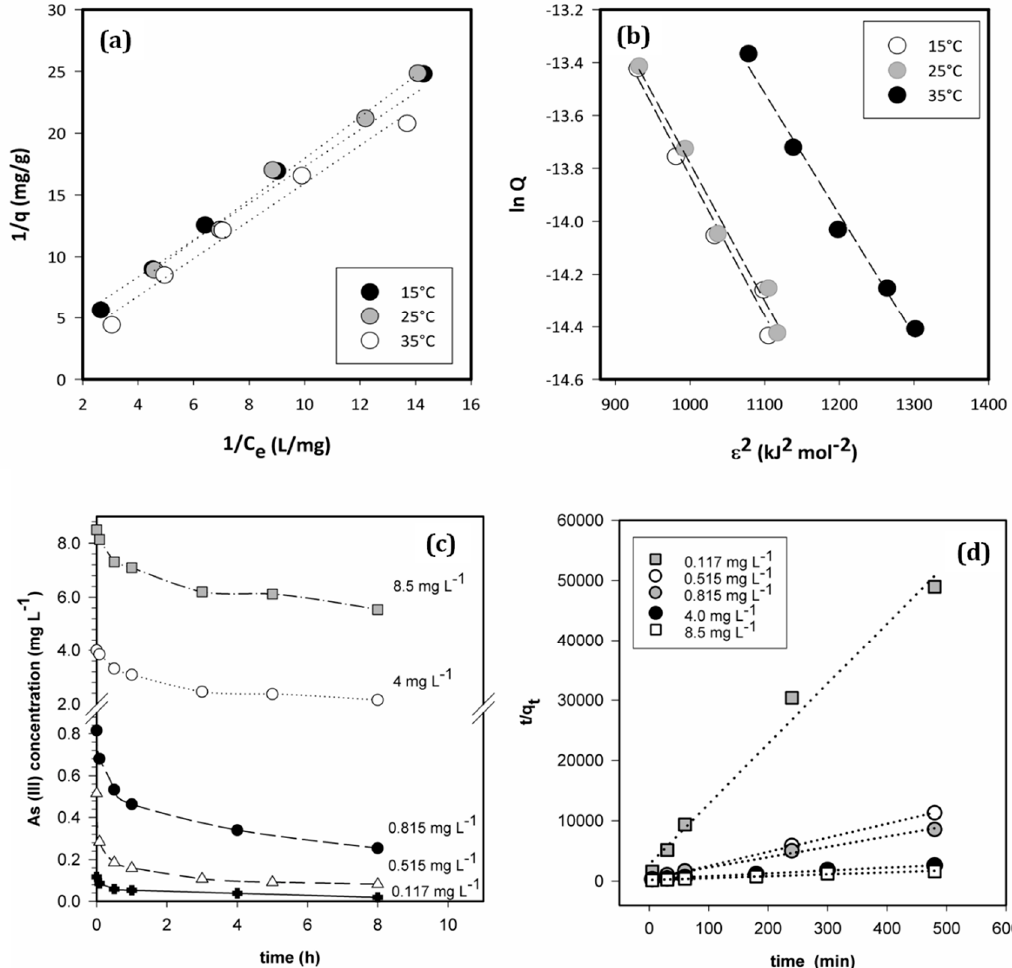
Figure 4. Adsorption isotherms ( a ) Langmuir and ( b ) DR, ( c ) effect of arsenic concentration, ( d ) kinetic model of pseudo-second order of As (III) adsorption on the Fe-modified W zeolite .